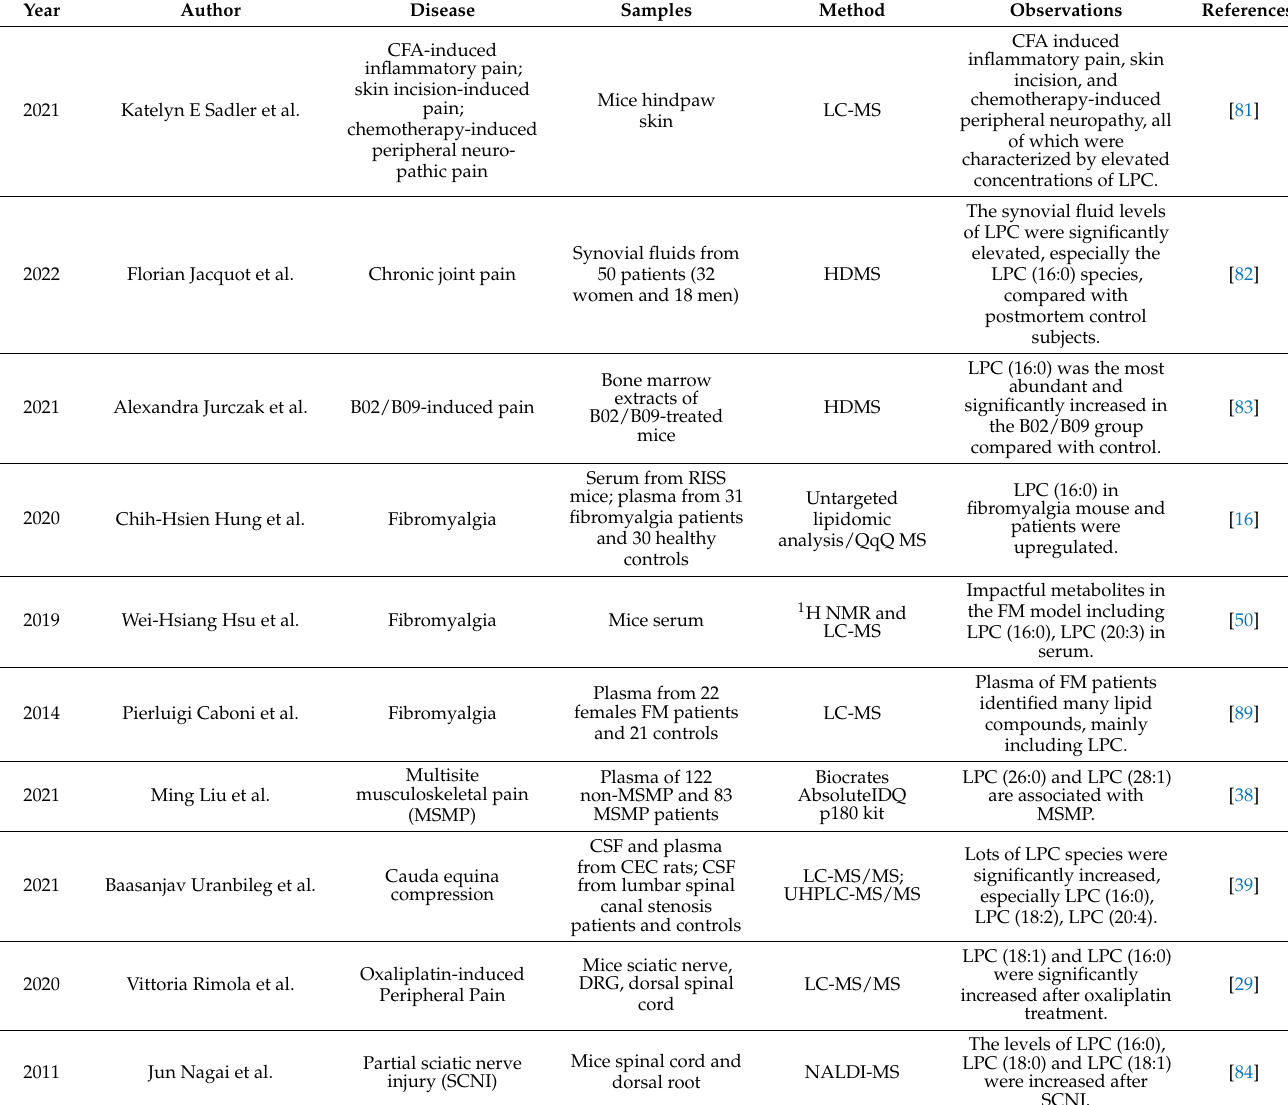
Table 2. The Application of LPC in Chronic